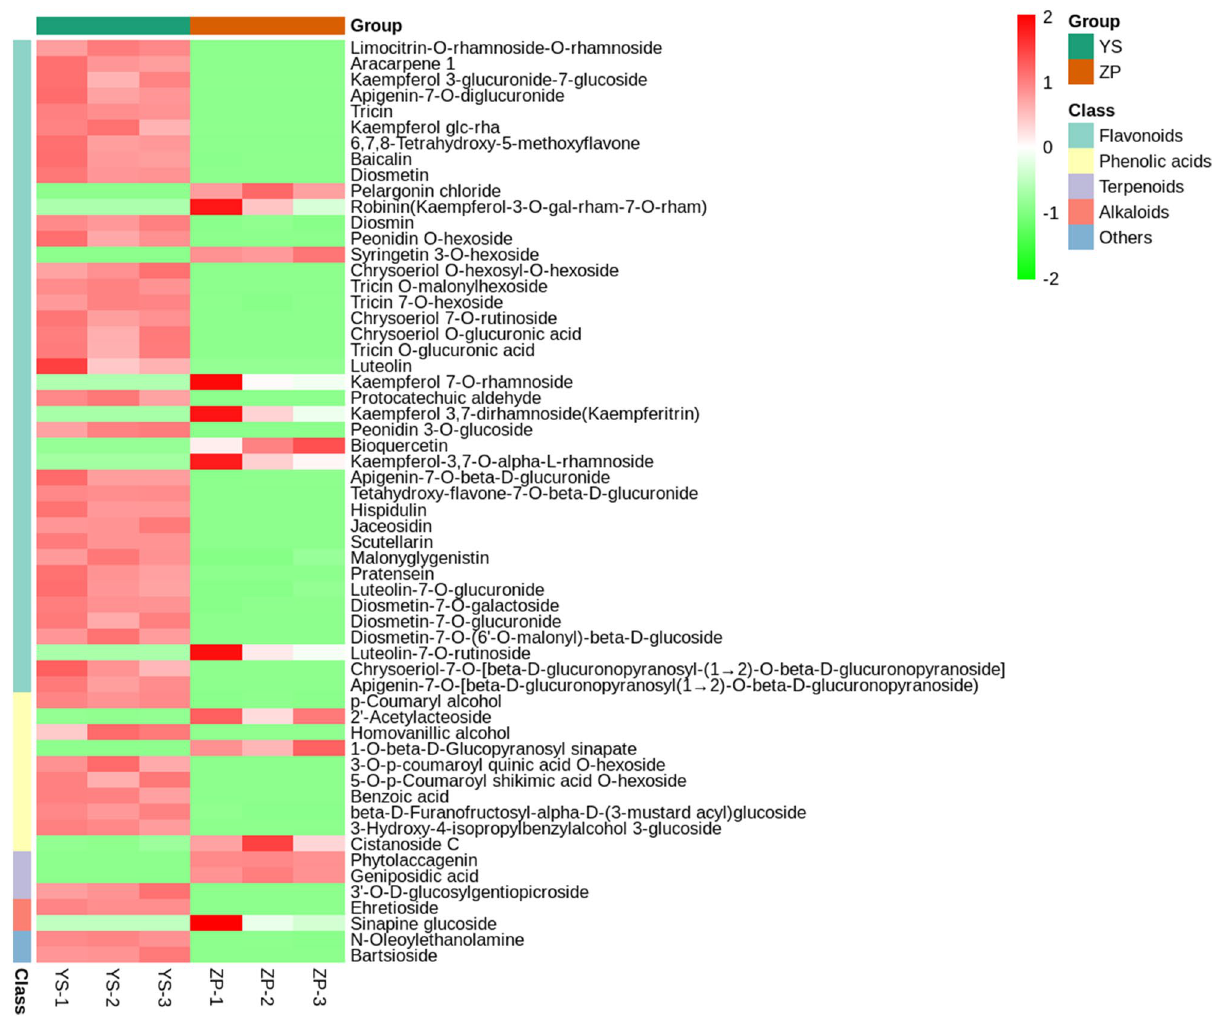
Figure 4. Heat map of 58 DMs. Ordinate: clustering after normalization of relative contents of different metabolites, 5 kinds of colors stand for 5 classes of metabolites, Abscissa: grouping of samples, 2 kinds of colors stand for 2 groups of samples, Color scale from green to red indicated the contents of differentially expressed metabolites vary from low to high. Heatmap visualized in ggplot2 toolkit of R v1.0.12 (https:// www.r- proje ct.